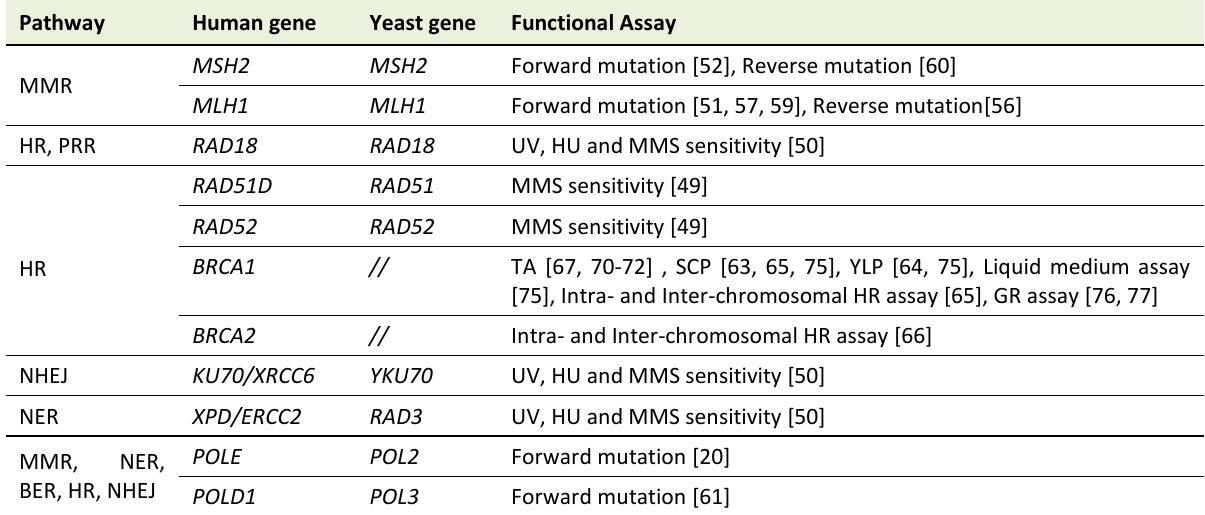
TABLE 1. DNA repair genes assayed in Saccharomyces cerevisiae .